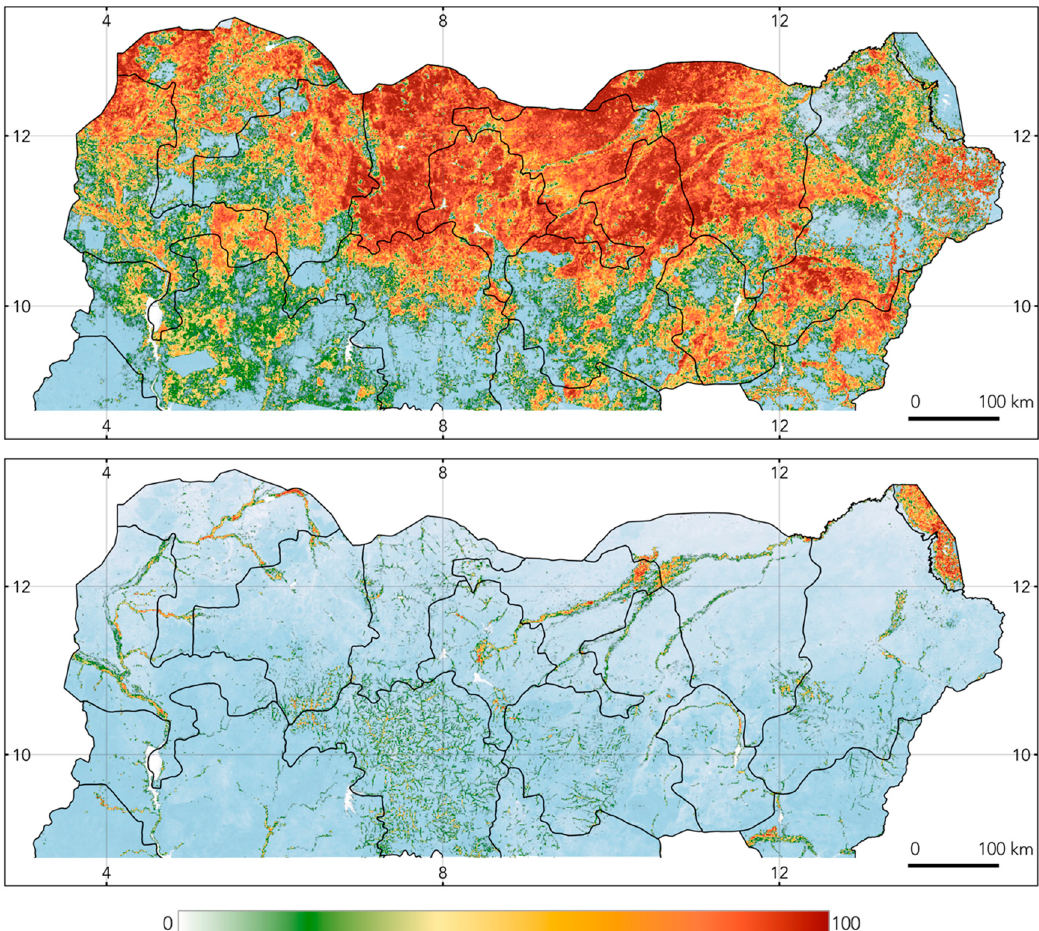
Figure 10. Northern Nigeria LCLU map, 1 km spatial aggregation. Upper plate: distribution of rain-fed agriculture; Lower plate: distribution of irrigated agriculture. Color bar represents percentage of cultivated land.